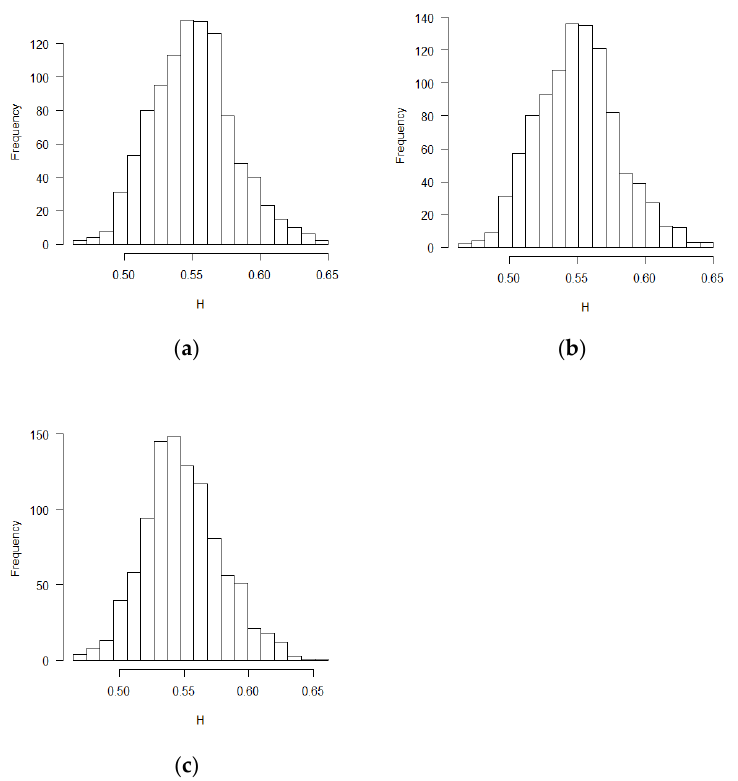
Figure 2. Histograms for estimated H values (PS design, ε ’s ~ increments of FBM, MLE method): ( a ) no covariate, ( b ) two discrete covariates, ( c ) two continuous covariates.